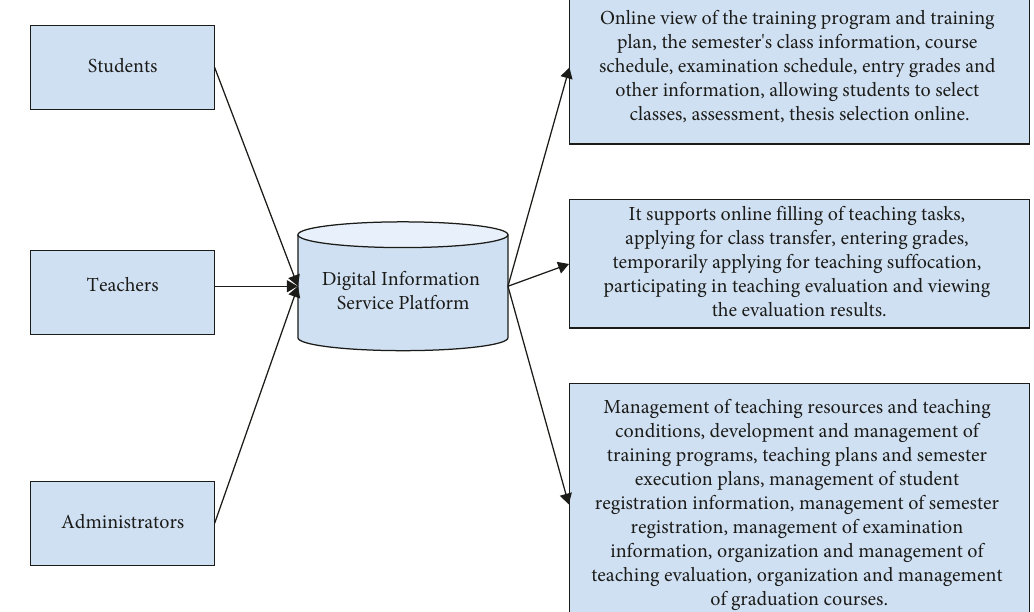
Figure 4: Functions and services of X College digital information service